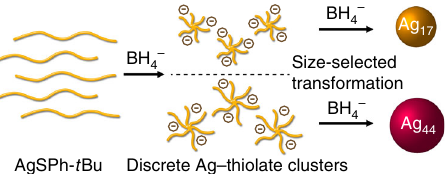
Fig. 2 Characterizations of fi nal products. a Negative-mode ESI-MS and b UV – Vis absorption spectrum of the fi nal reaction product. Species with m / z larger than 4000 can also be assigned to Ag fragments. See Supplementary Fig. 1 for more detailed